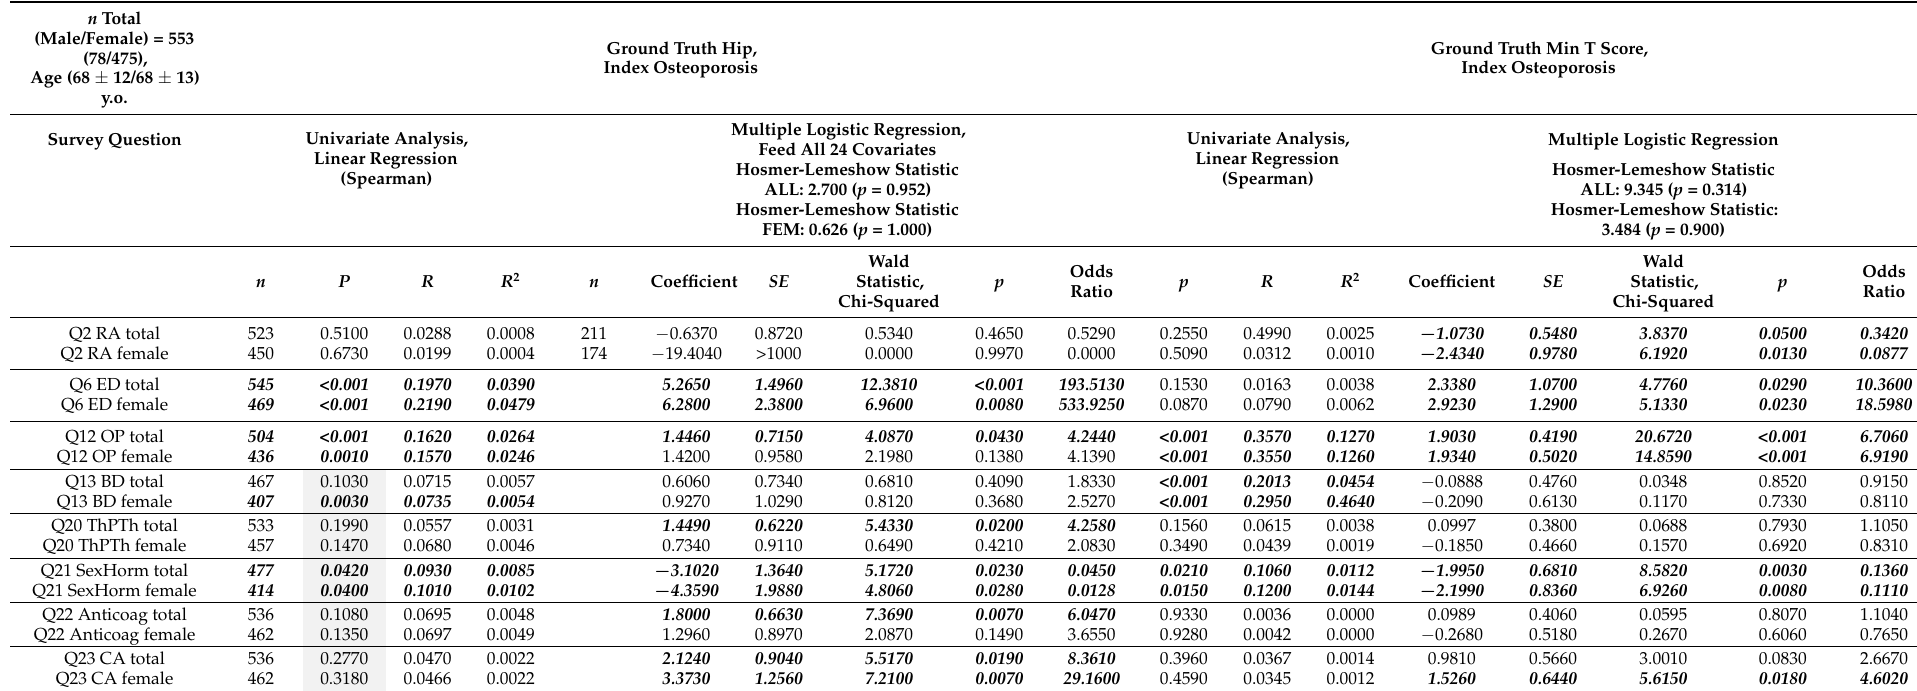
Table 1. Risk factor correlation with increased osteoporosis